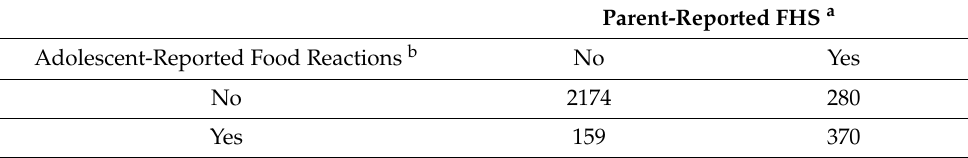
Table 5. Parent-reported food hypersensitivity (FHS) vs. adolescent-reported food